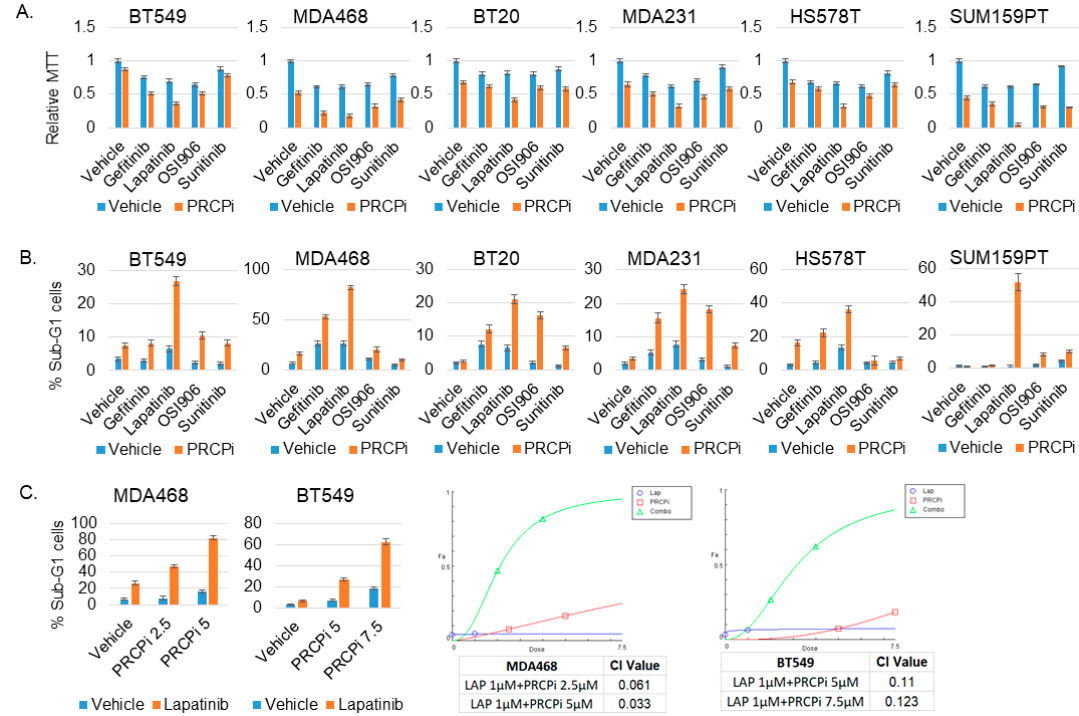
Figure 8. PRCPi and lapatinib synergistically kills TNBC cells. The indicated cell lines were treated with a vehicle, PRCPi (5 µM for 5 cell lines, 10 µM for SUM159PT), Gefitinib (0.5 µM), Lapatinib (2 µM), OSI906 (2 µM), and Sunitinib (0.2 µM), alone or combination of PRCPi with Gefitinib, Lapatinib, OSI906, or Sunitinib, for three days. Cells were analyzed for MTT absorbance ( A ) or % Sub-G1 cells ( B ). Average (8 replicate) relative MTT absorbance and Average (triplicate) % Sub-G1 cells are presented with SD indicated. ( C ) To determine drug synergy, cells were treated with two